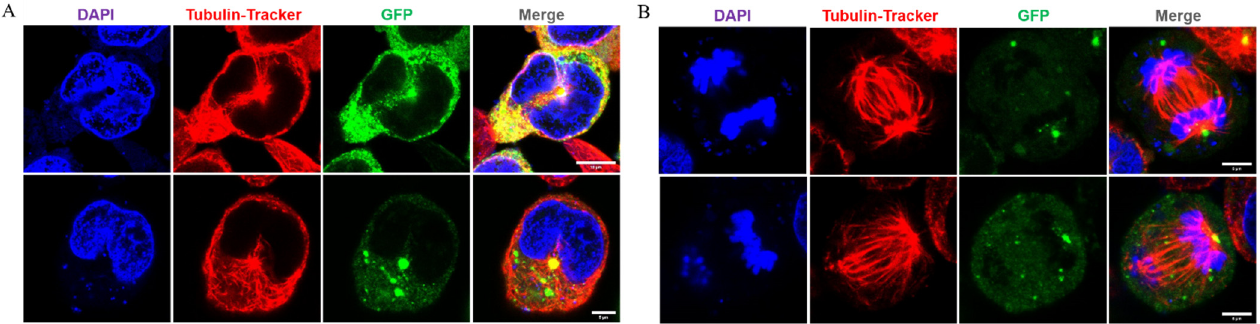
Figure 9. ( A ) Co-positioning of reflectins and the cytoskeleton in the cell center, in interphase cells, with the scale bars = 10 µm. ( B ) Positioning of reflectins in the spindle center at the late stage of cell division, with the scale bars = 5 µm. Nuclei and microtubules are stained with DAPI (blue) and Tubulin-Tracker Red (red); RA1 is indicated by tandem EGFP (green); Yellow comes from the merging of green and red [36]. Copyright 2022, Frontiers Publishing Group.